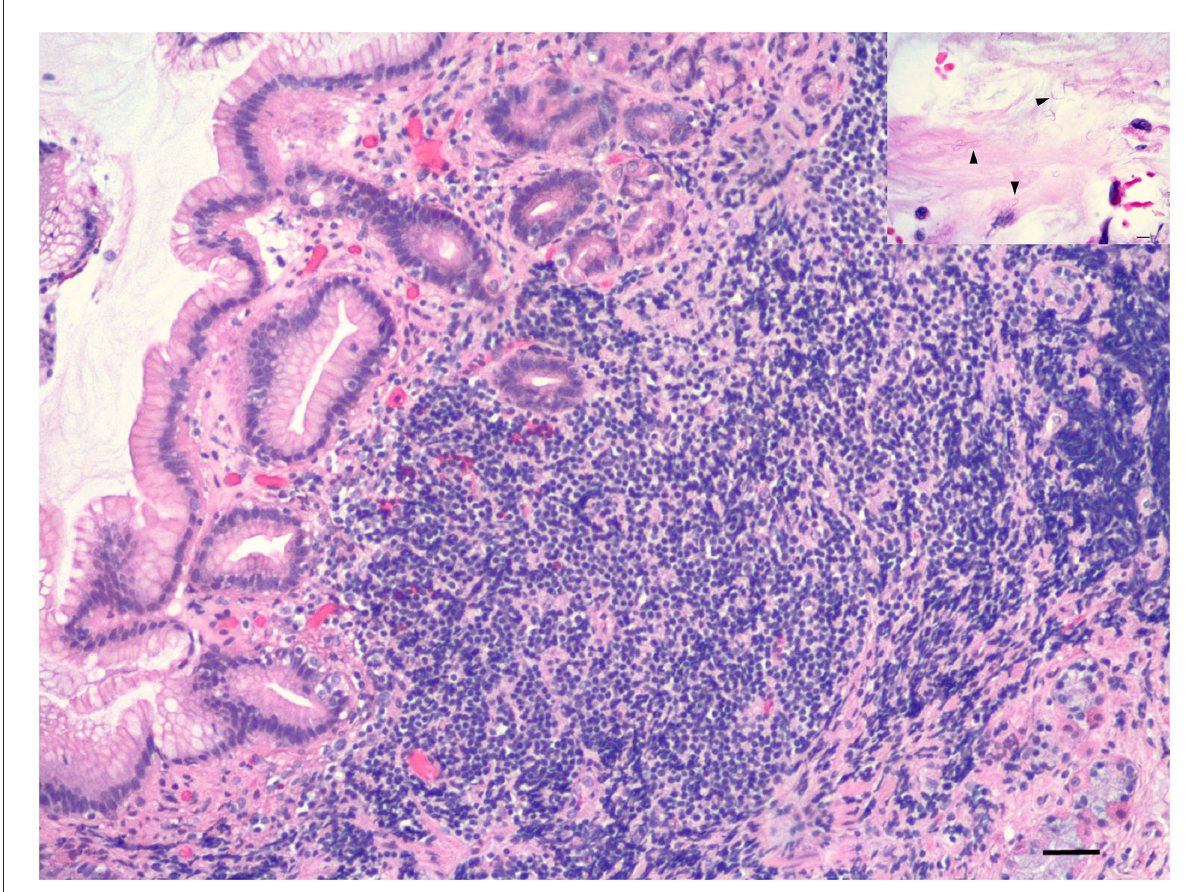
FIGURE3 Histopathology of fundic cup biopsies. Stomach with lymphoplasmacytic gastritis, 10x magnification, scale bar: 100 µ m. Inset shows spiral bacteria ( Helicobacter spp.) (arrowheads) in surface mucus of stomach, 60x magnification, scale bar: 15 µ